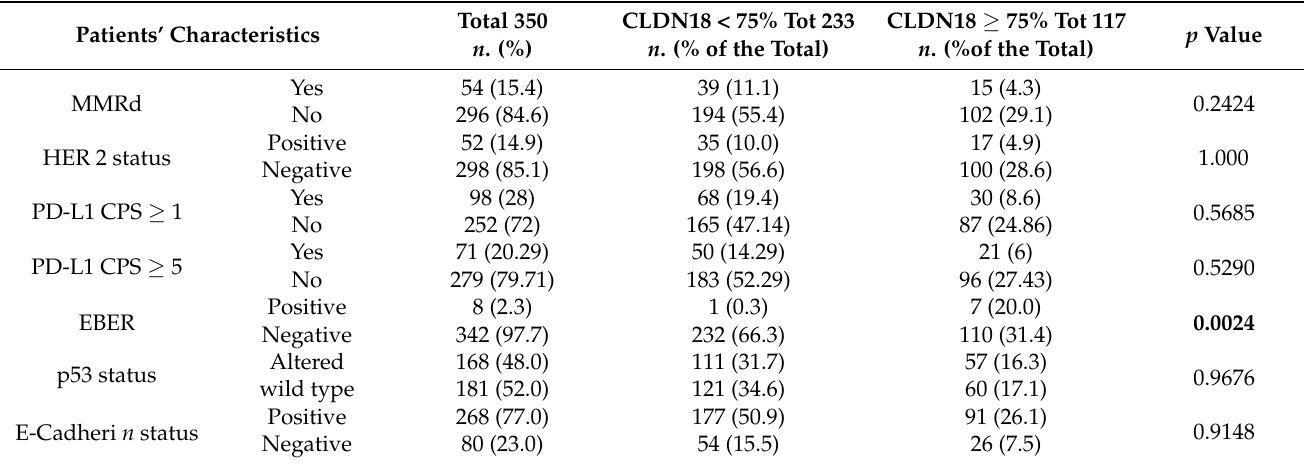
Table 2. Immunohistochemical profiling of the considered series according to CLDN18 status (note that the sum of patients does not add to 350 patients for all the parameters due to missing clinical data or exhausting tumor tissue). Patients’